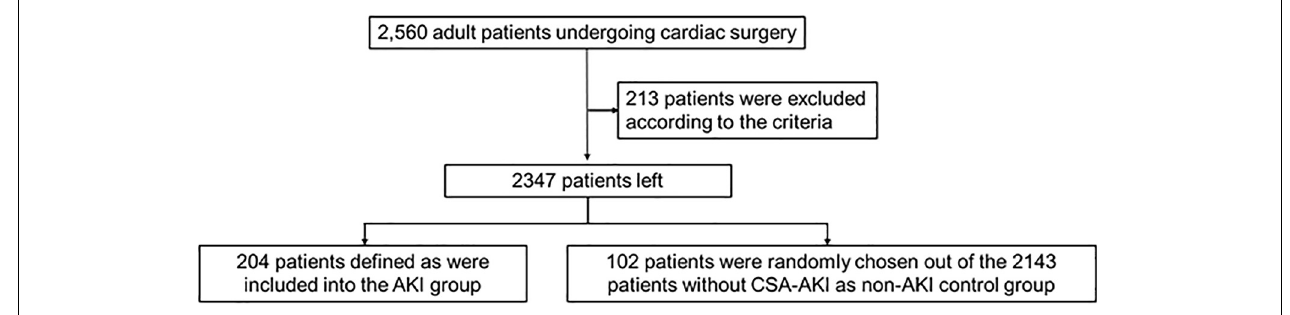
FIGURE 1 | Flowchart of patients